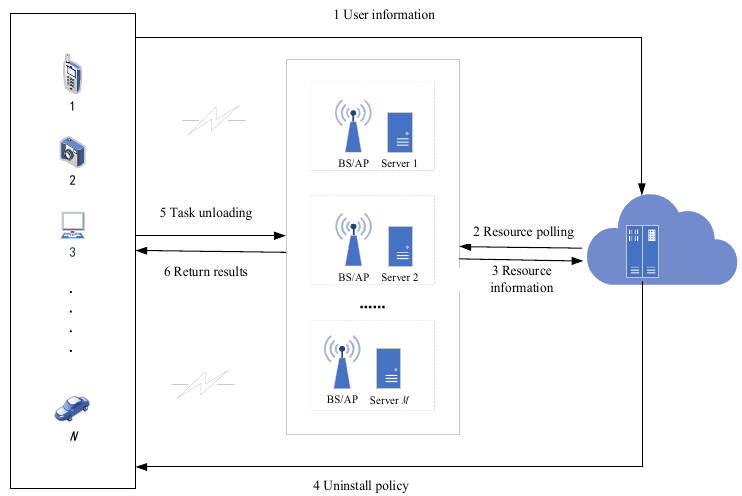
Figure 1. Cloud-Edge collaboration system model.